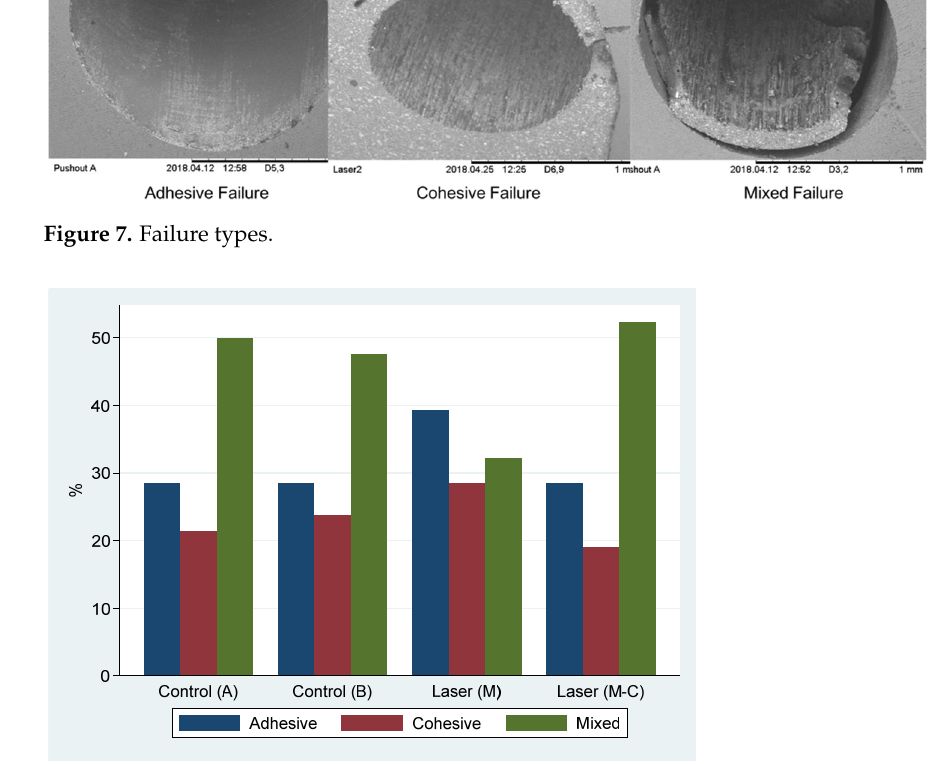
Figure 8. Distribution of failure type by the group.